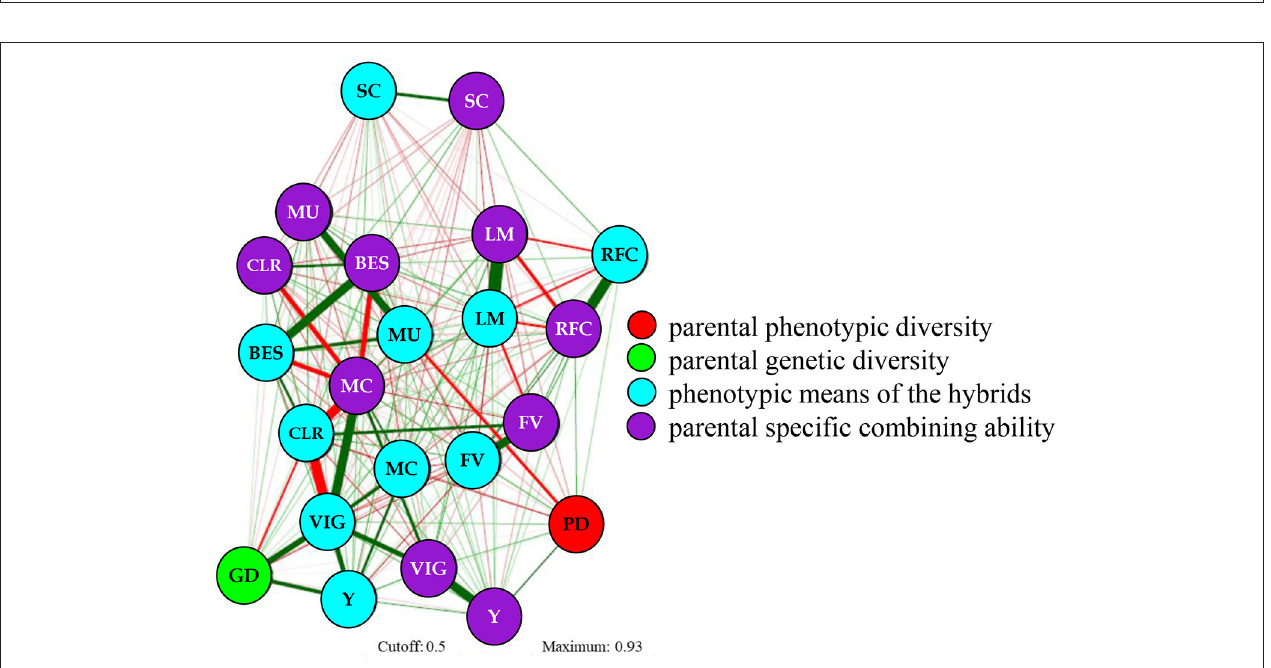
FIGURE 3 | Estimated means of parents and hybrids and values for the heterosis of 12 F 1 hybrids (H14 to H58— Table 3 ) obtained in a circulating diallel scheme, based on the means of agronomic traits.